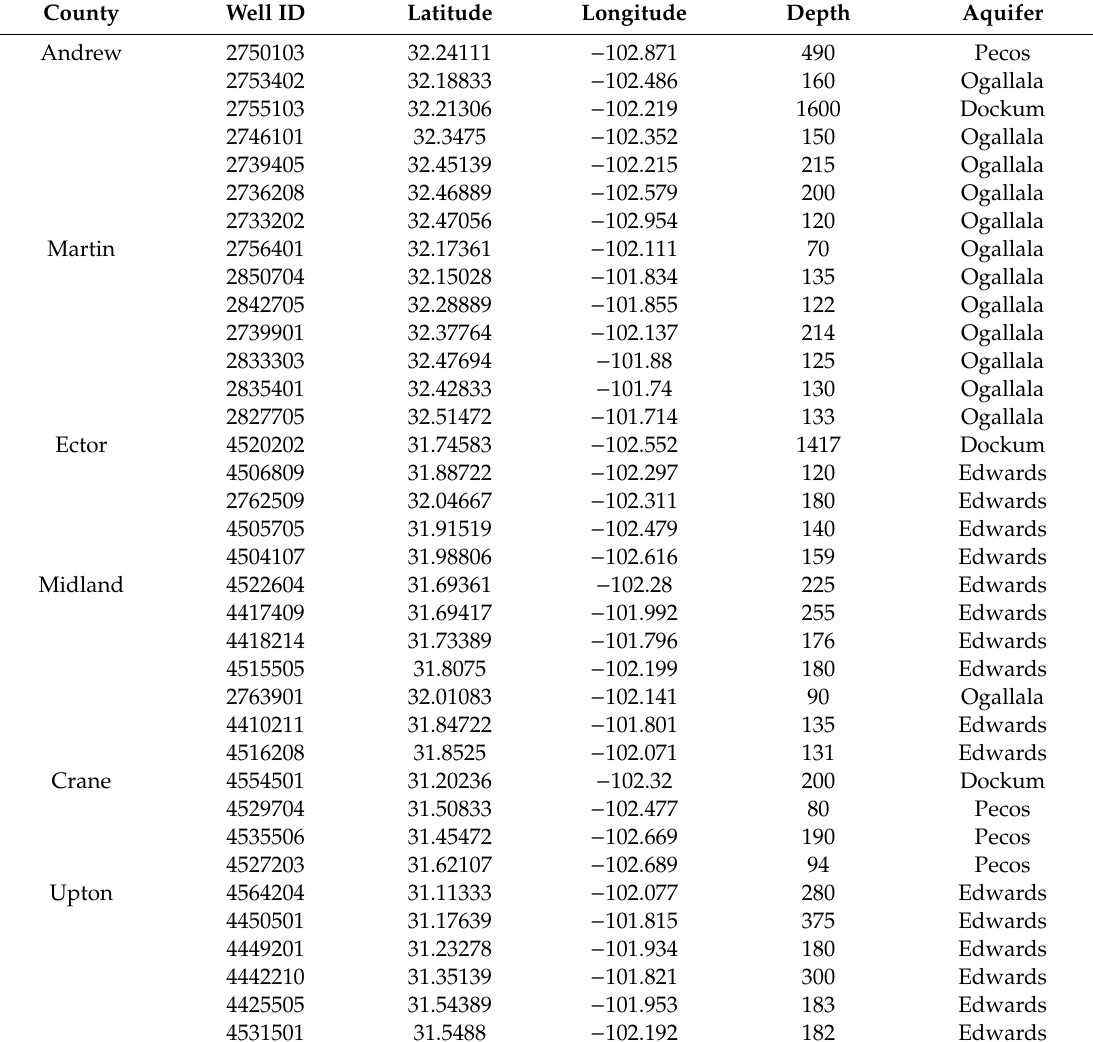
Table 1. Summary of well data used in the study area (depth unit: feet. below land surface).